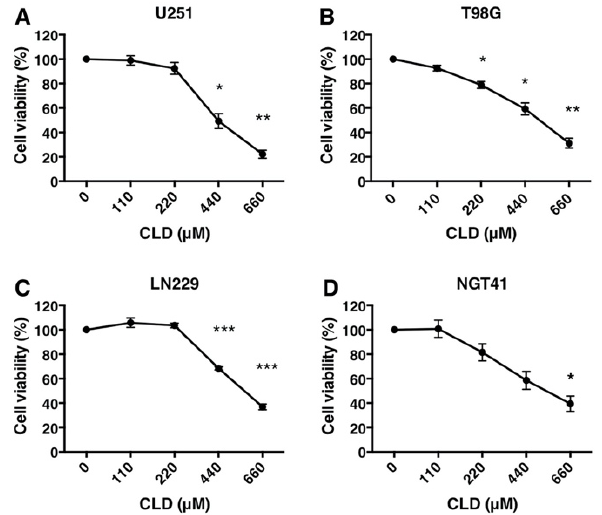
Figure 1. Cytotoxic effects of clindamycin on cultured glioblastoma cell lines. Dose responses of clindamycin (CLD) on cell viability in glioblastoma cell lines ( A – D ). Cells were treated with CLD (0, 110, 220, 440, or 660 μ M) for 72 h and subjected to a WST-1 cell viability assay. The viability of untreated cells (vehicle control: 0 μ M CLD) was considered 100%. Data are presented as the mean ± SE. Similar results were obtained from triplicate experiments (* p < 0.05, ** p < 0.01, and *** p < 0.001 vs. control culture: one-way ANOVA).